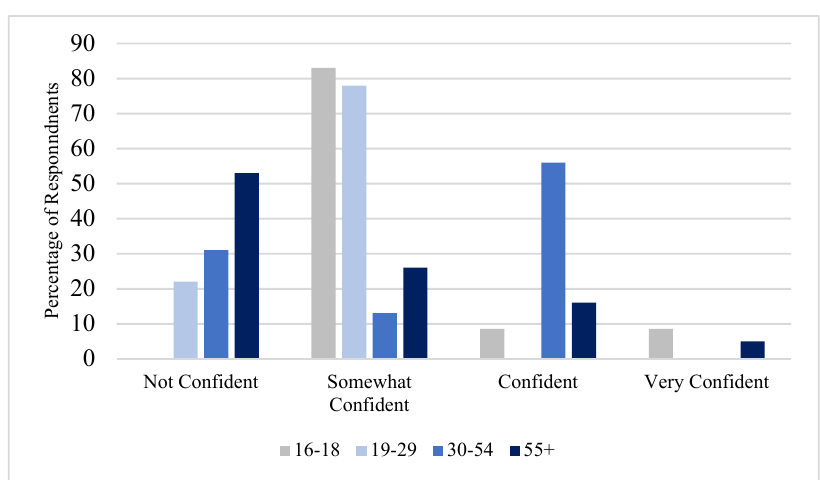
Figure 4. Confidence in Tap Water by Age.